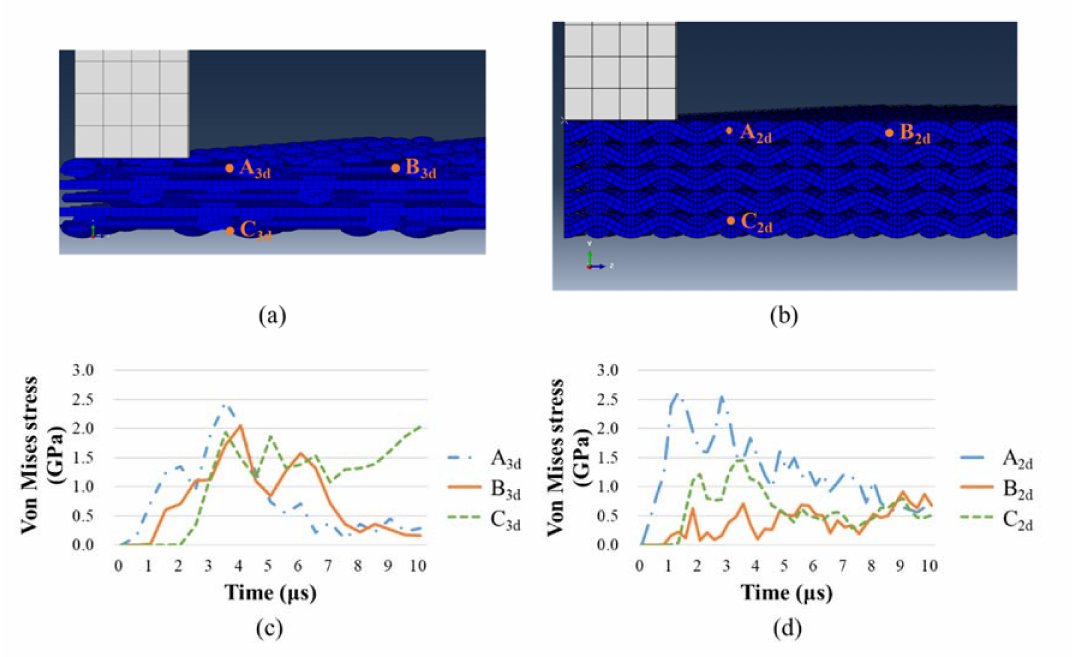
Figure 13. The node positions through the weft direction of ( a ) 5-AI and ( b ) 5-plain; and the stress response of the nodes in ( c ) 5-AI and ( d ) 5-plain.